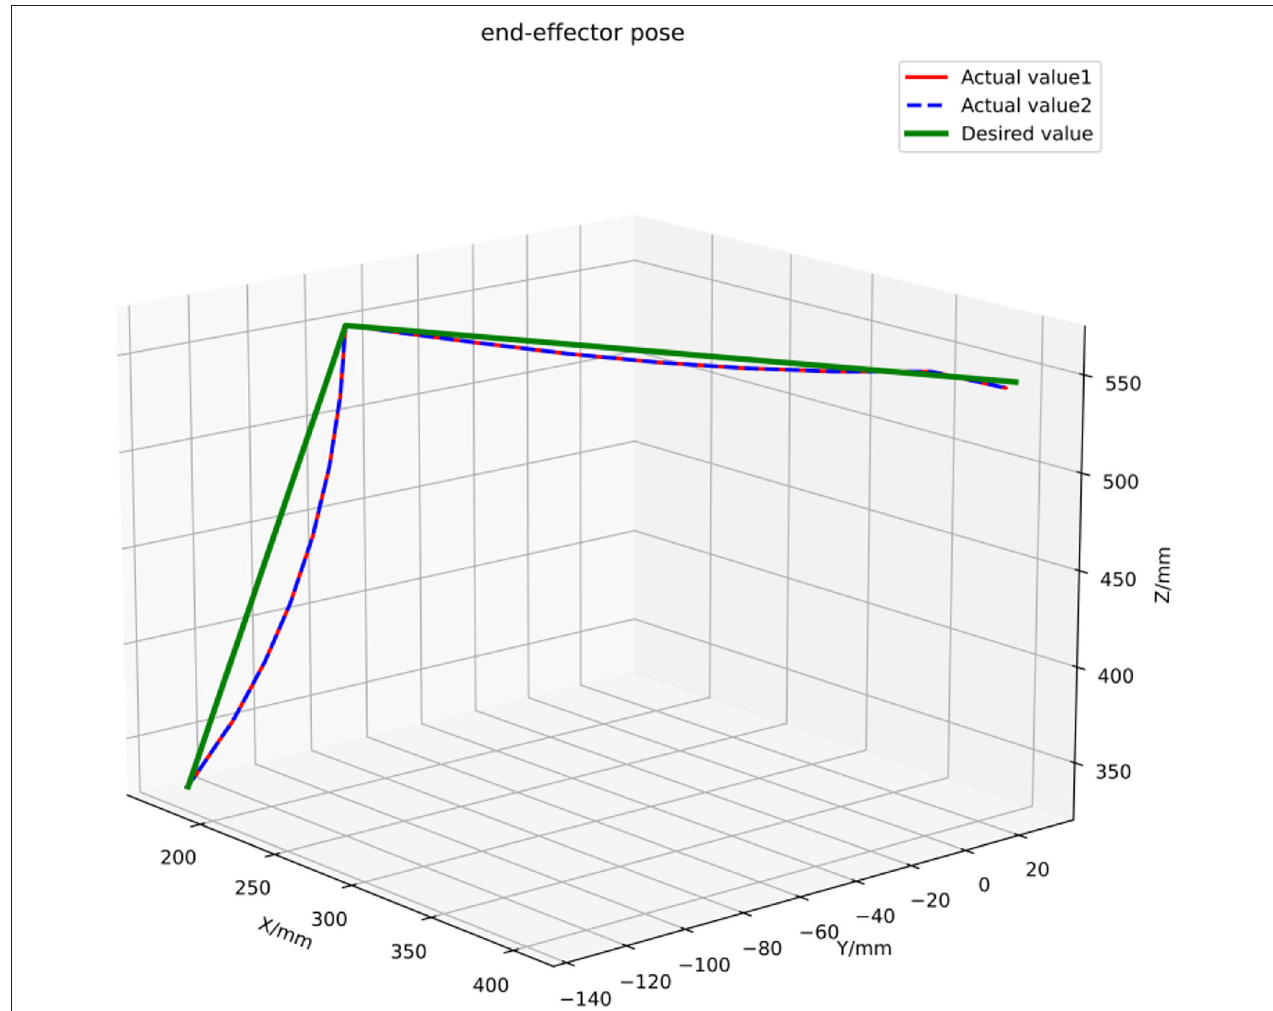
FIGURE 14 | Actual trajectory of the robot in the assembly task in 3D space.